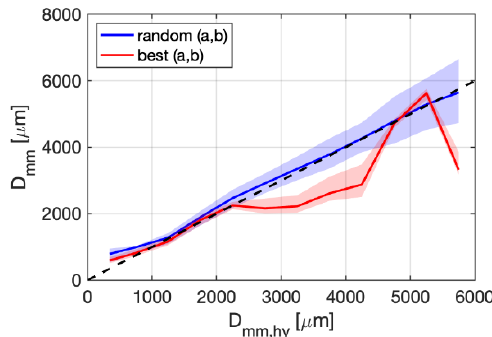
Figure 7. The D mm derived by D mm , hy -dependent m–D relationship compared to the D mm , hy . The blue and red solid line represent the mean D mm derived from random equally plausible ( a , b ) solutions and the best estimate of ( a , b ) that minimizes χ 2 in each D mm , hy bins respectively. The lower and upper bounds of shading areas with corresponding colors indicate the 25% and 75% percentiles of D mm in each D mm , hy bins.